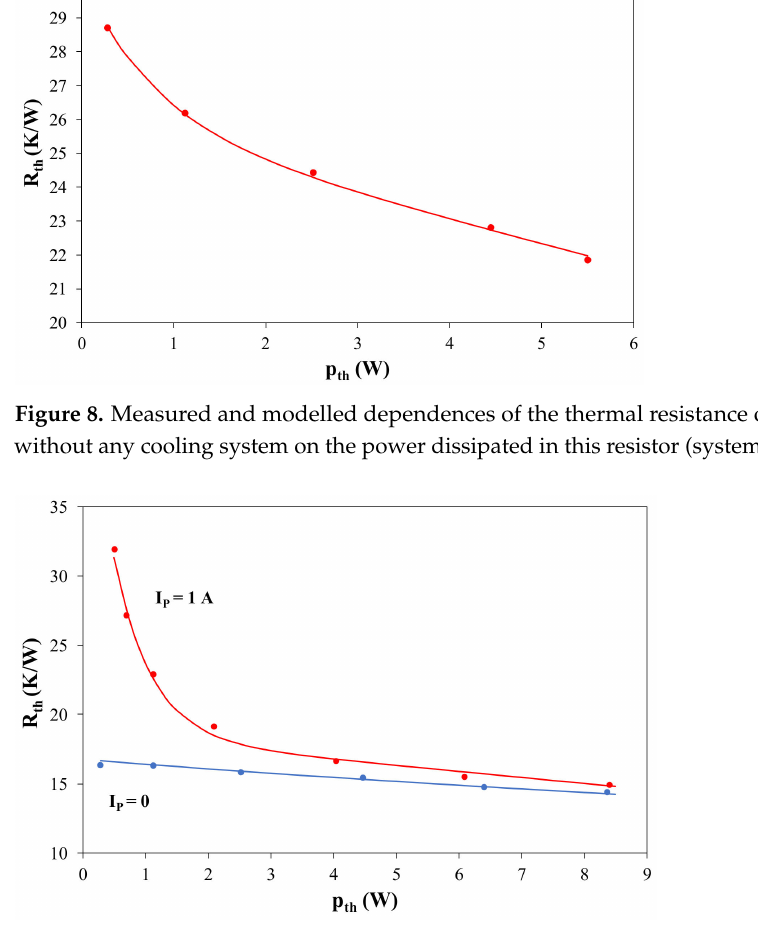
Figure 9. Measured and modelled dependences of the thermal resistance of the resistor co-operating with the Peltier module on the power dissipated in this resistor at selected values of current I P (system